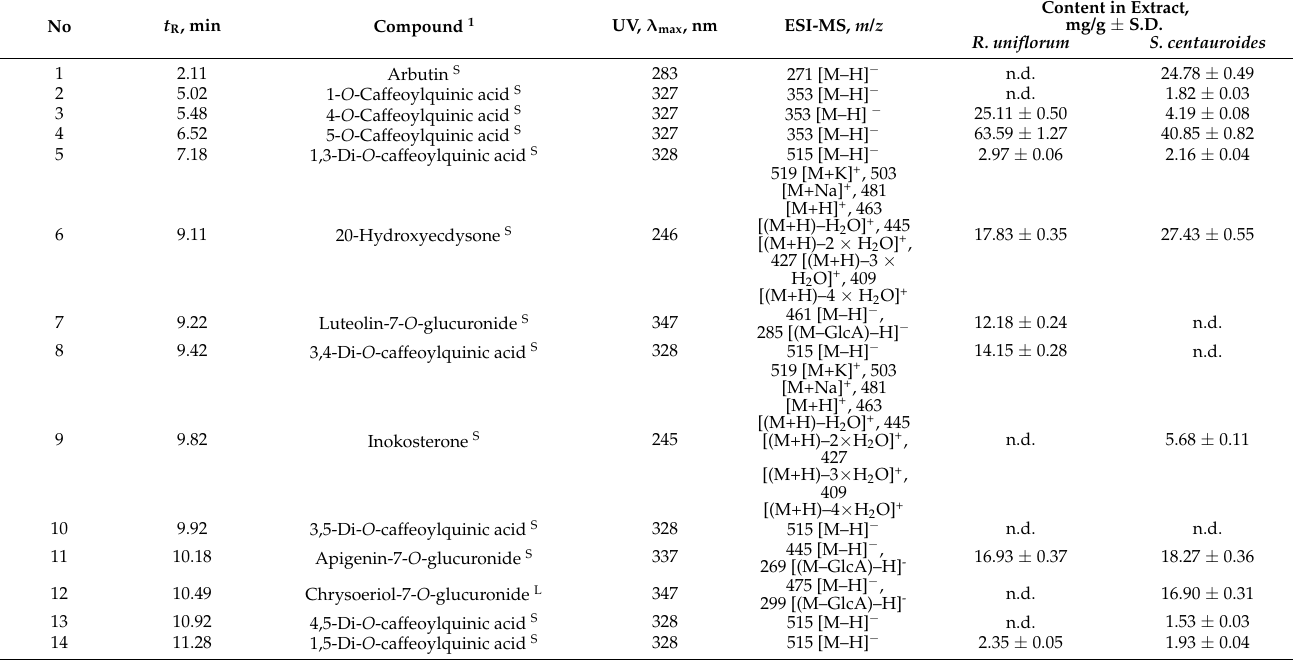
Figure 1. High-Performance Liquid Chromatography with Photodiode Array Detection (HPLC-PDA) chromatograms ( λ 254 nm) and High-Performance Liquid Chromatography with Mass Spectrometric Detection (HPLC-MS) in Selective Ione Monitoring (SIM mode) chromatograms of total extracts of Rhaponticum uniflorum and Serratula centauroides herbs. Compounds are numbered as listed in Table 1. Table 1. Retention times ( t R ), UV- and ESI-MS spectral data, and content of compounds 1 – 14 found in Rhaponticum uniflorum and Serratula centauroides herb